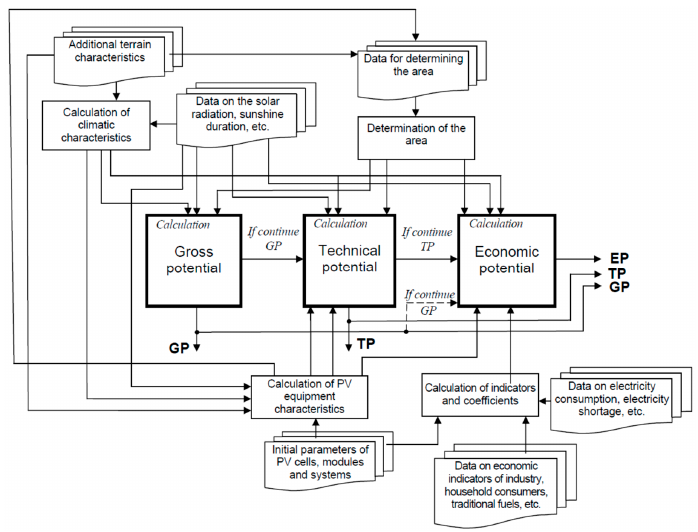
Figure 3. General diagram of calculation logic.